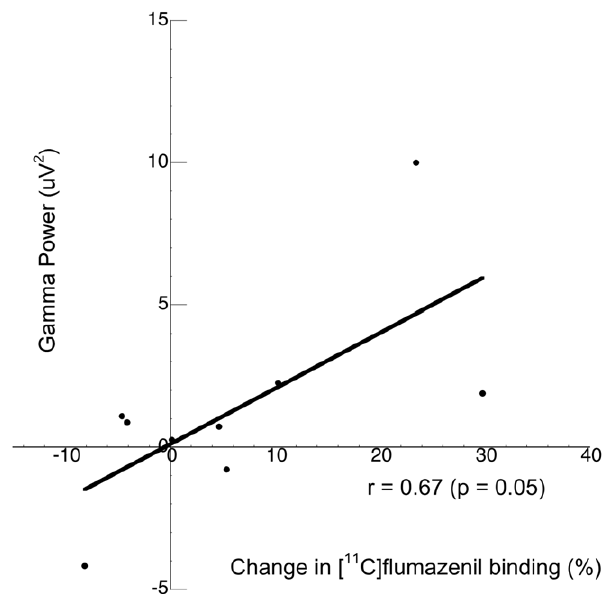
Figure 1. The ability to increase GABA levels in the orbito- frontal cortex, measured as the change in [ 11 C]flumazenil binding in response to GAT1 blockade, predicts (r=0.67, p=0.05) the ability to entrain cortical networks, measured via EEG gamma oscillations.